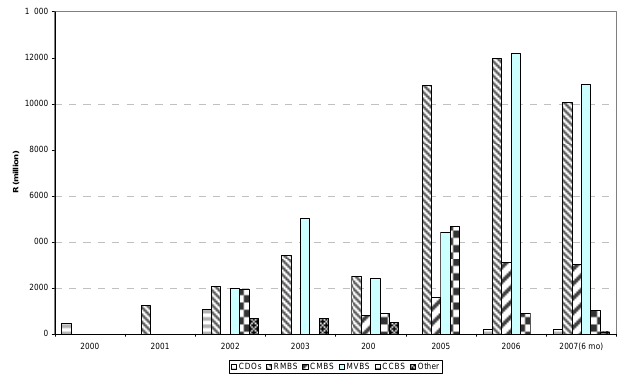
Figure 2: Securitisation issuance by classification